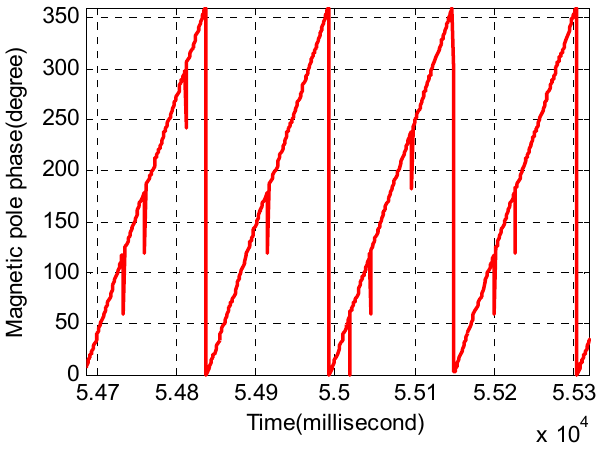
Figure 6. The magnetic pole phase because of